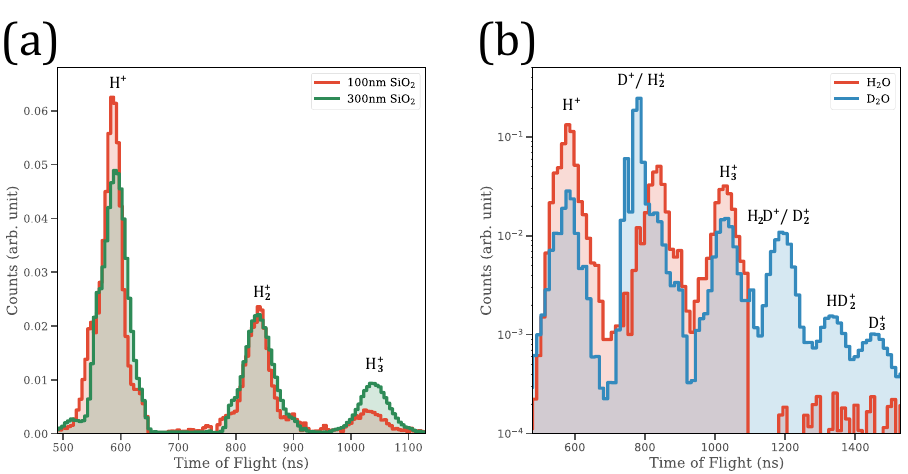
Fig. 1 Emitted ions from the surfaces of nanoparticles. a Comparison between two TOF spectra from two experiments (red/green lines) with different conditions including size of nanoparticles (100 and 300 nm), concentration of sample (3 and 1.5 g/L), and laser intensity at 2 × 10 14 W/cm 2 serving as an evidence for the formation of H þ . b Comparison between ions emitted from the surfaces of 100 nm silica nanoparticles inhabited by H 2 O and D 2 O 3 molecules at 3 g/L concentration and irradiated by a laser intensity of 2 × 10 14 W/cm 2 . The presence of D þ adsorbed on nanoparticles presents unequivocal evidence about the source of the trideuterium ions (for extended TOF spectra, cf. Supplementary Fig. 4). Source data are provided as a Source Data fi